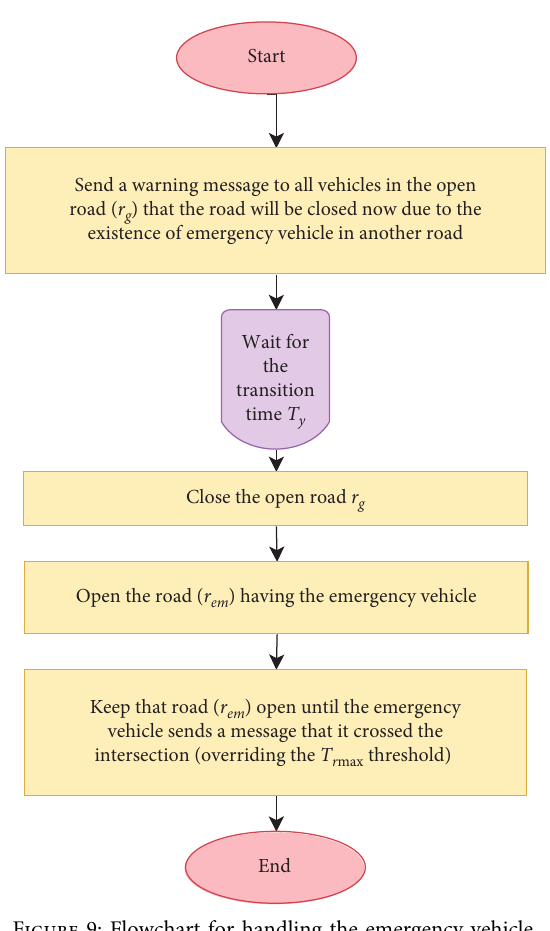
Figure 9: Flowchart for handling the emergency heading angle (d1, d2, d3, d4, d5, etc. as in Fig- ure 6) for each road that joins that intersection.